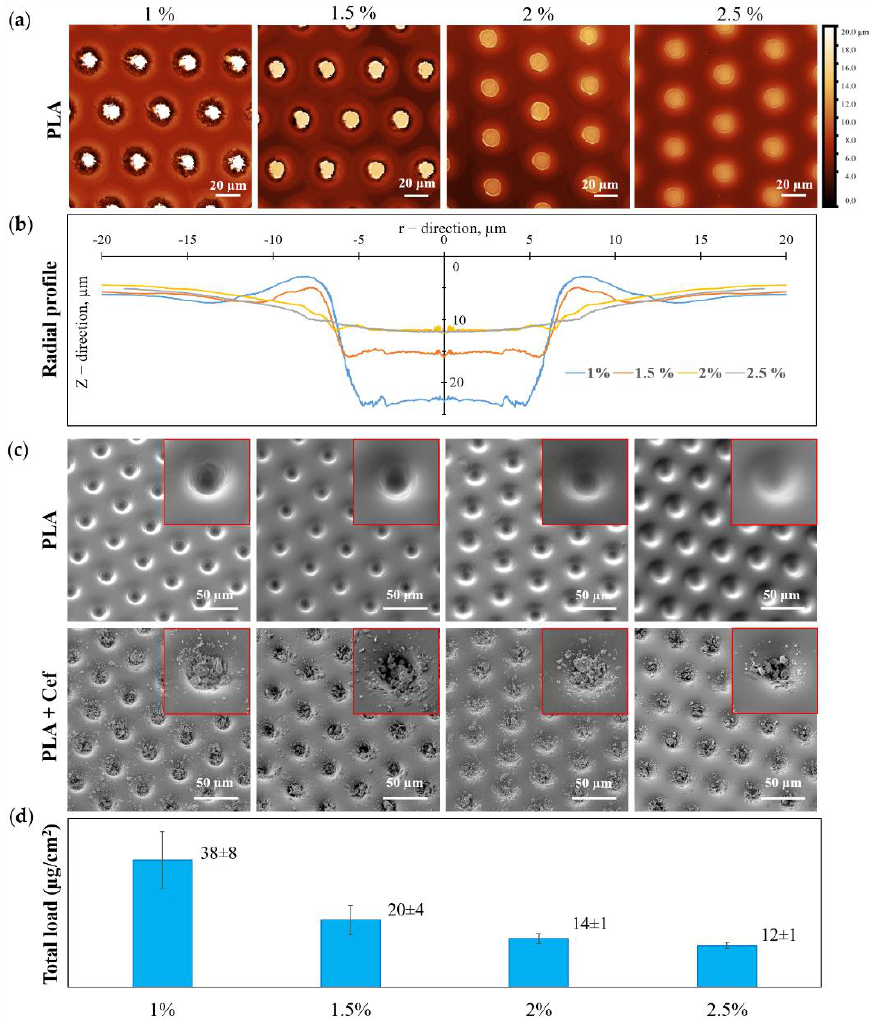
Figure 3. The dependence of the microwells shape and the microchambers loading efficiency with ceftriaxone on the initial PLA solution concentration: CLSM heightmap ( a ) and radial profile of the patterned film PLA ( b )); SEM images of the patterned film of PLA (first row) and PLA with ceftriaxone (second row) ( c ); a total load of ceftriaxone in microchamber arrays ( d ).